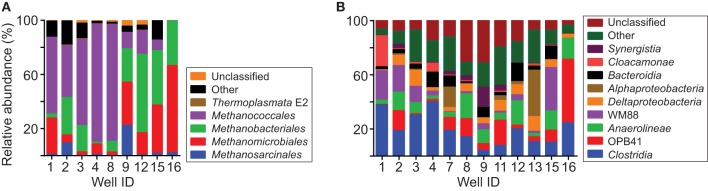
Taxonomic distribution of 16S rRNA sequences. Chart (A) shows the distribution of sequences classified within orders of Archaea. Relative abundances are shown for all of the groups of methanogens detected in the analysis. Chart (B) shows the distribution of sequences grouping within classes of Bacteria. For clarity, only classes with average relative abundance per sample >2% are specifically identified.